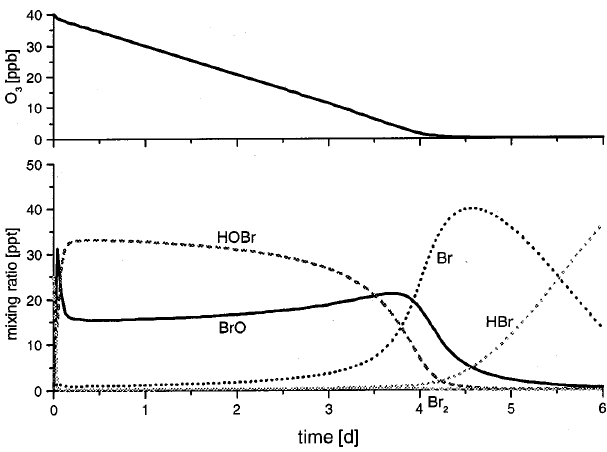
Fig. 12. Model calculation: time-dependent development of O 3 and bromine compounds assuming a rapid heterogeneous oxidation of Br (cid:255) by HOBr on the ice cap forming Br